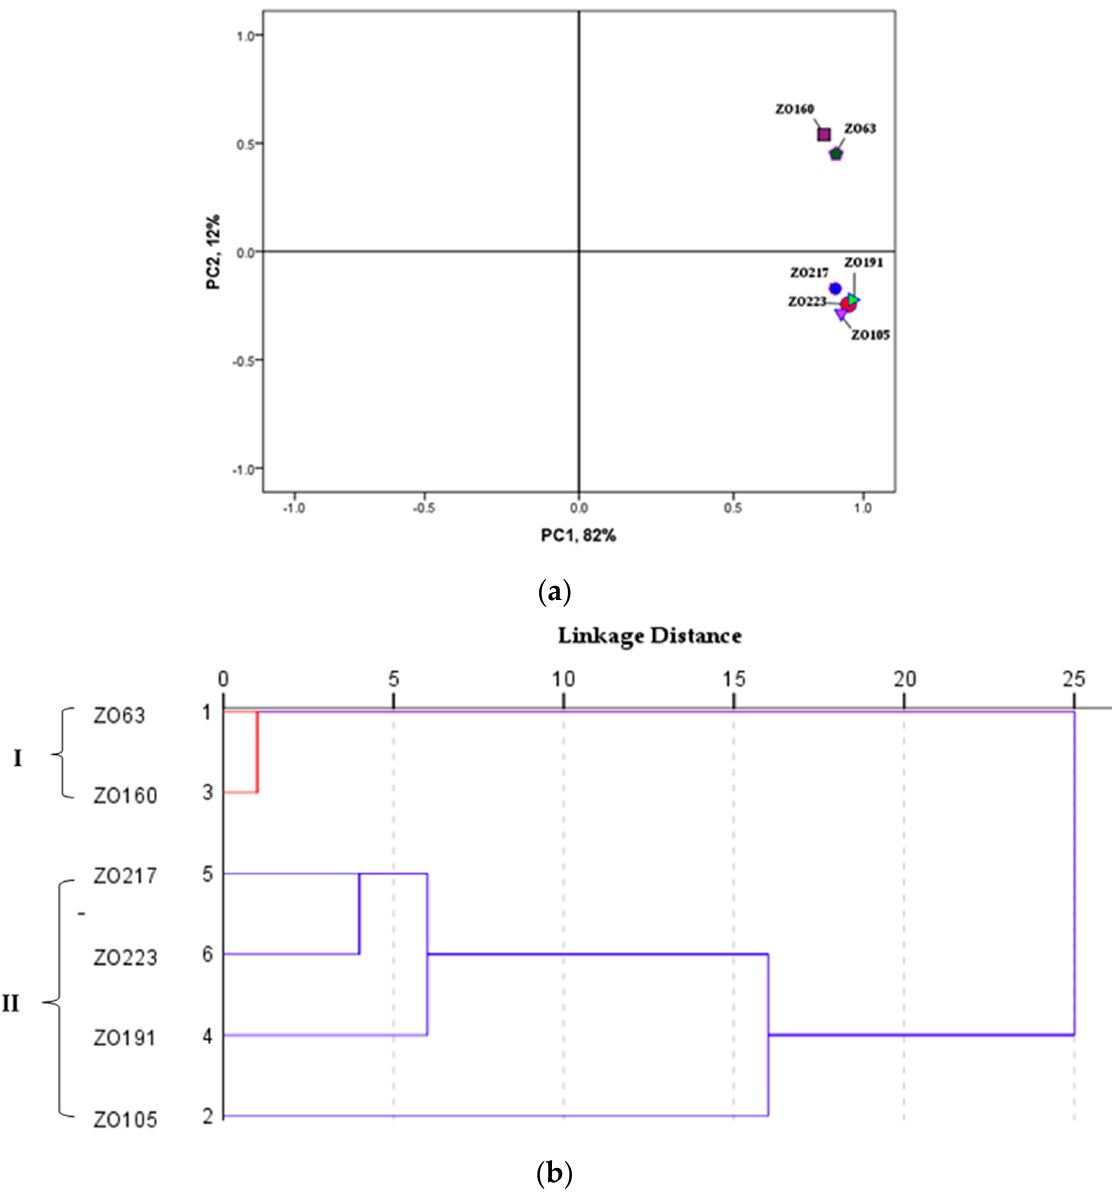
Figure 3. ( a ) The generated PCA plot and ( b ) hierarchical cluster analysis (HCA) dendrogram showing the clustering pattern based on the Euclidean distance between Z. barbatum groups. The principal components PC1 and PC2 accounted for 94% of the total variance.